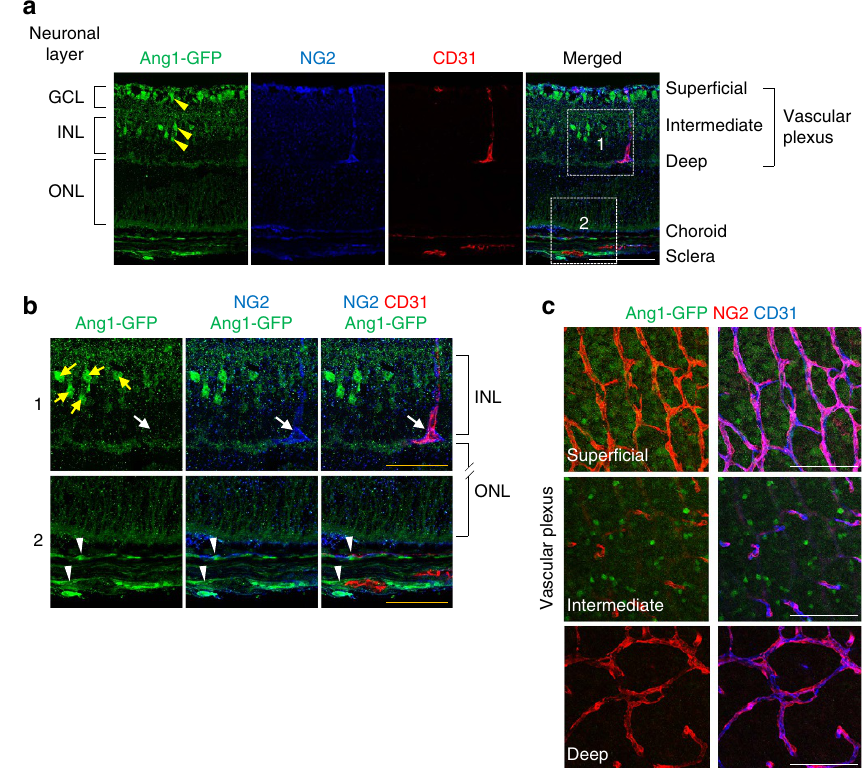
Figure 4 | Pericyte is not a source of Ang1 in the retinal vessels. ( a , b ) Cross-sectional images of retina of Ang1 -GFP knock-in mouse at P5. Note that most of GFP signals are detected in the retinal neurons (yellow arrowheads) located in ganglion cell layer and inner nuclear layer. Magnified images of boxed areas are shown below. No GFP signal was detected in NG2 þ pericytes around retinal vessels (arrows), whereas positive GFP signal was detected in NG2 þ pericytes around choroidal vessels (white arrowheads). ( c ) Images showing localization of GFP þ cells in relation to CD31 þ retinal vessels and NG2 þ pericytes in superficial, intermediate, and deep retinal vascular layers. GFP signals are not detected in pericytes or ECs, but detected in neurons that surround retinal vessels in superficial and intermediate vascular plexus layers. Scale bars, 100 m m (white) and 50 m m